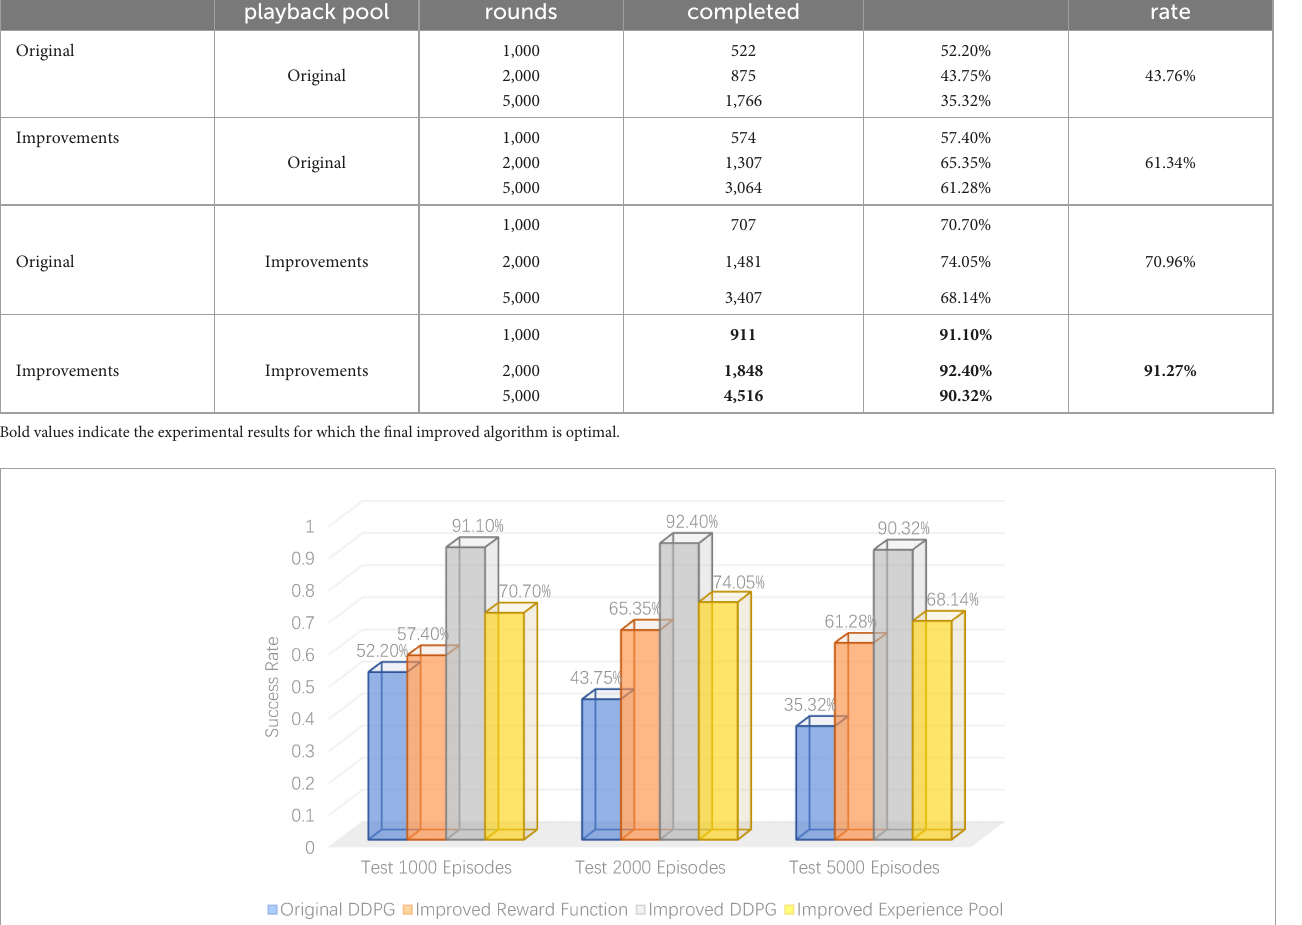
TABLE 1 Comparison of robot arm arrival task success rates before and after deep deterministic policy gradient (DDPG) algorithm improvements. Reward functions